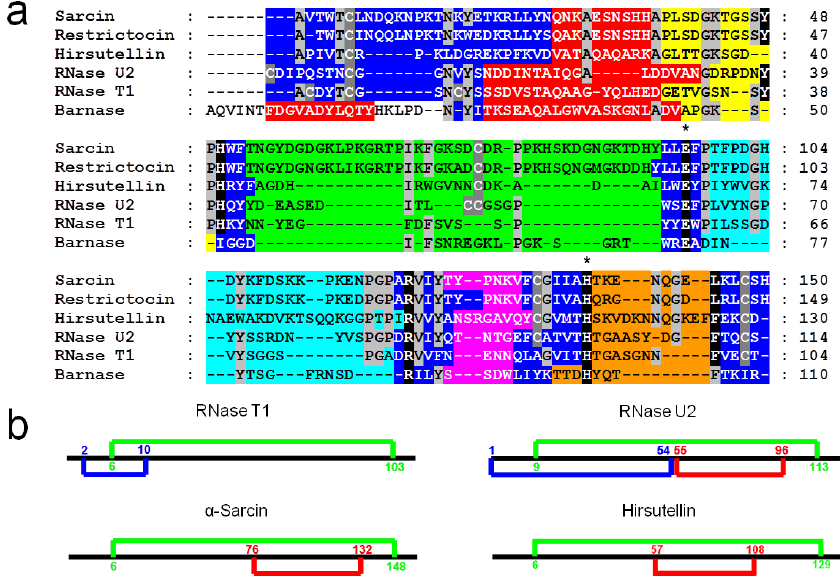
Figure 1. ( a ) Alignment of the amino acid sequences of (cid:68) -sarcin, restrictocin, hirsutellin A, RNase U2, RNase T1, and Barnase. Conserved residues (light grey boxes) in at least four sequences are enlightened, as well as the cysteine residues (dark grey boxes). Residues implicated in the active site are highlighted in black and essential catalytic residues are remarked by ( * ). Elements of secondary structure are displayed by colors: (cid:69) -hairpin, (dark blue boxes), residues at the helical portion, (red boxes) and residues in loops 1, 2, 3, 4, and 5 (yellow, green, light blue, pink, and orange boxes, respectively). ( b ) Comparison of the disulfide bridges arrangement in the Barnase